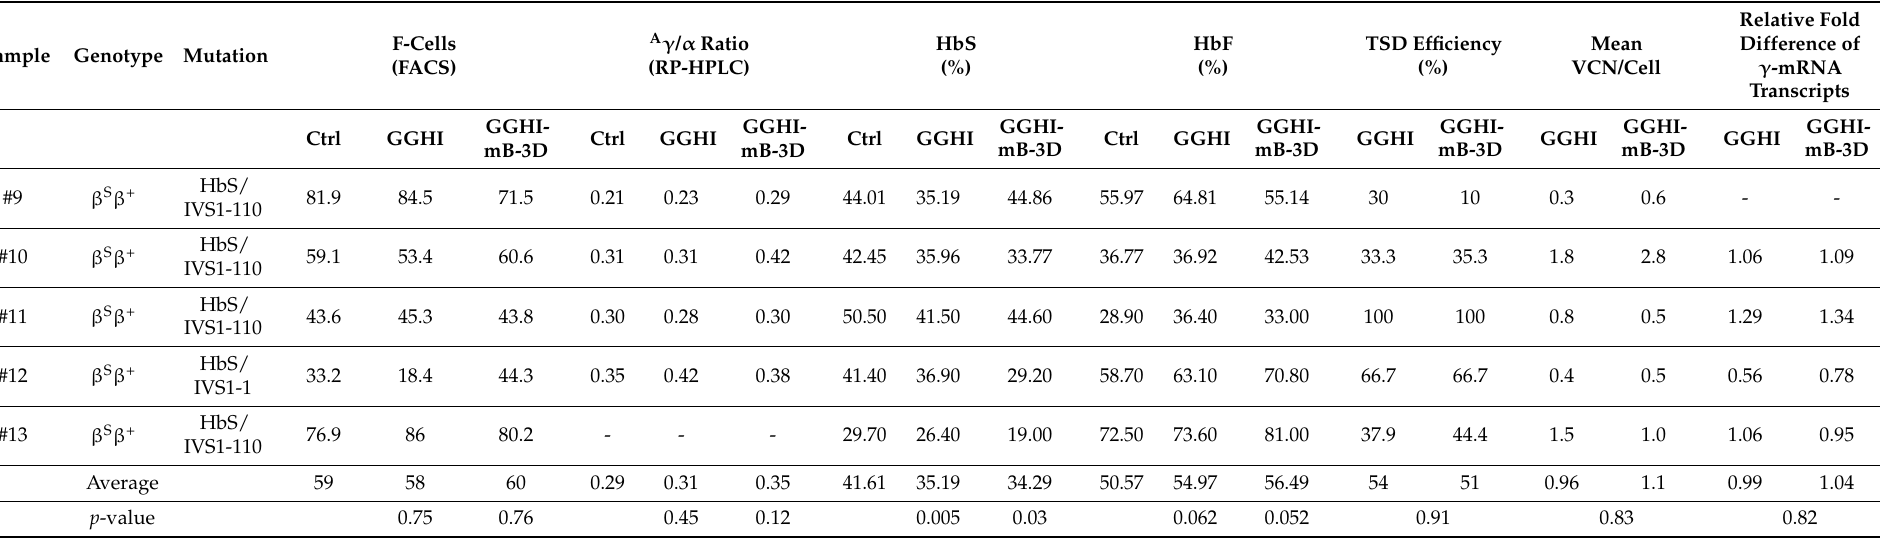
Table 3. Detailed results from β S β +